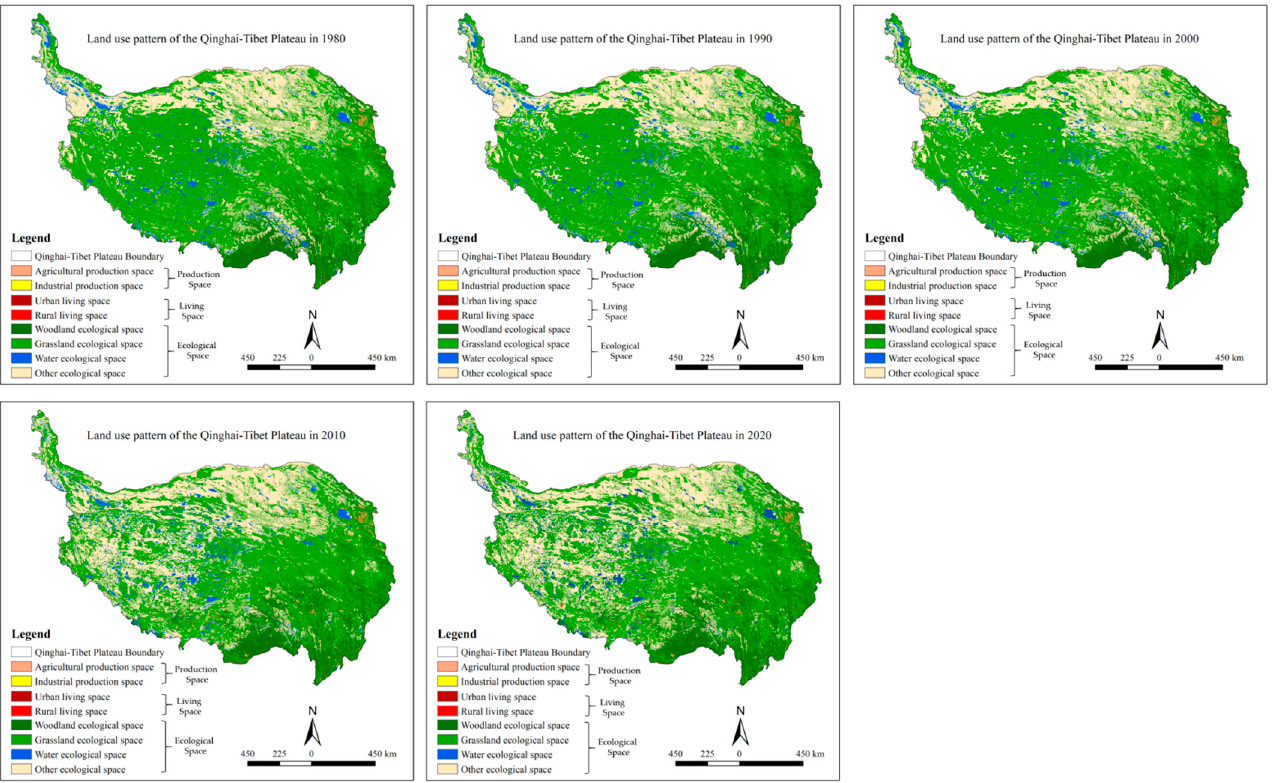
Figure 3. The pattern of the PLES from 1980 to 2020.